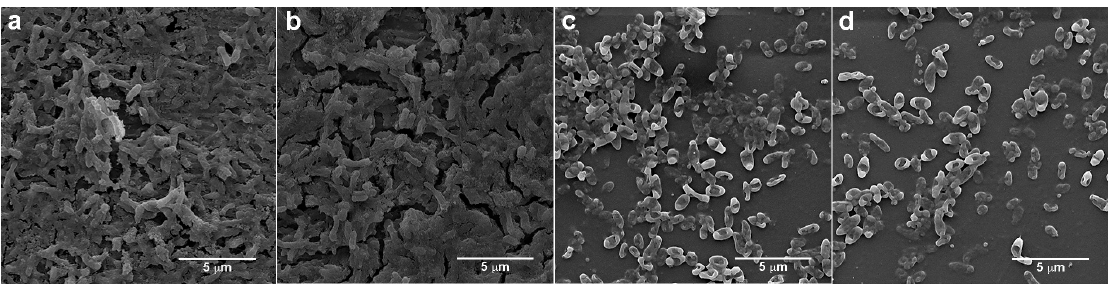
Figure 7. Pseudomonas aeruginosa incubated for 24 h on ( a ) AA2024, ( b ) AA2024 + TE, ( c ) AA2024 + PMMA, and ( d ) AA2024 + TE + PMMA.